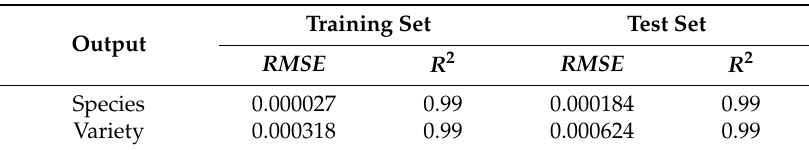
Table 7. Performance of the ANN model.